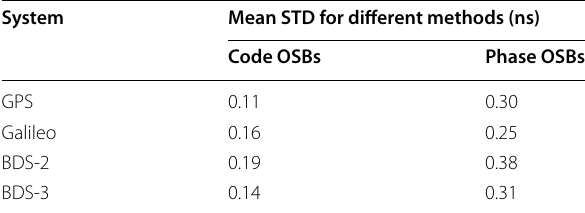
Note that Mean STD is the average of STD values of all the satellite OSBs without significant outliers, such as those of E14, E18, and C12 satellites.